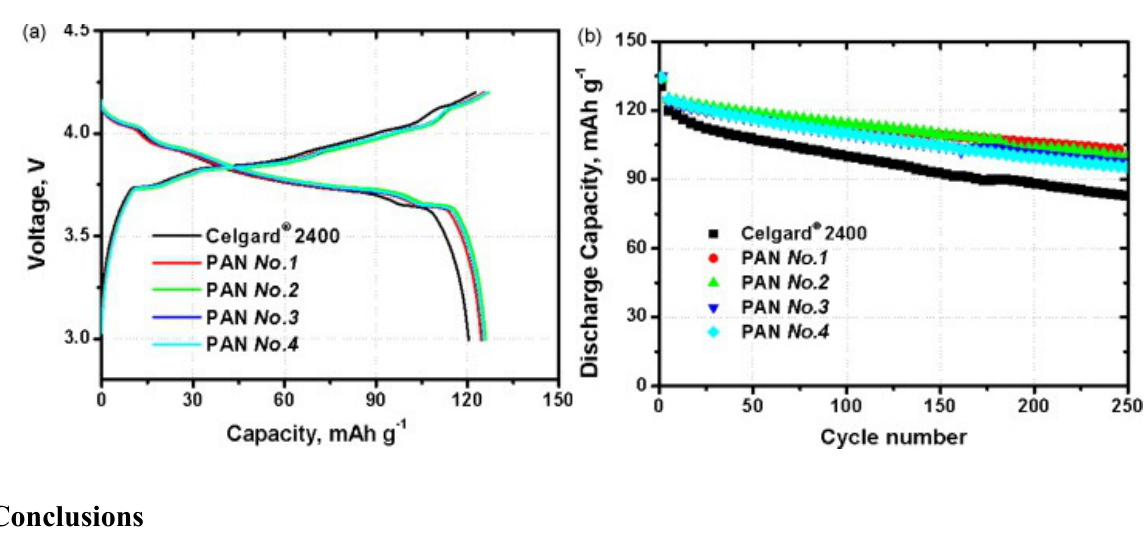
Figure 12. ( a ) Initial charge-discharge curves for the cells with the Celgard membrane and the Poly(acrylonitrile) (PAN) nonwoven membranes; ( b ) Discharge capacities vs. cycle numbers of the test cells at the 0.5 C rate